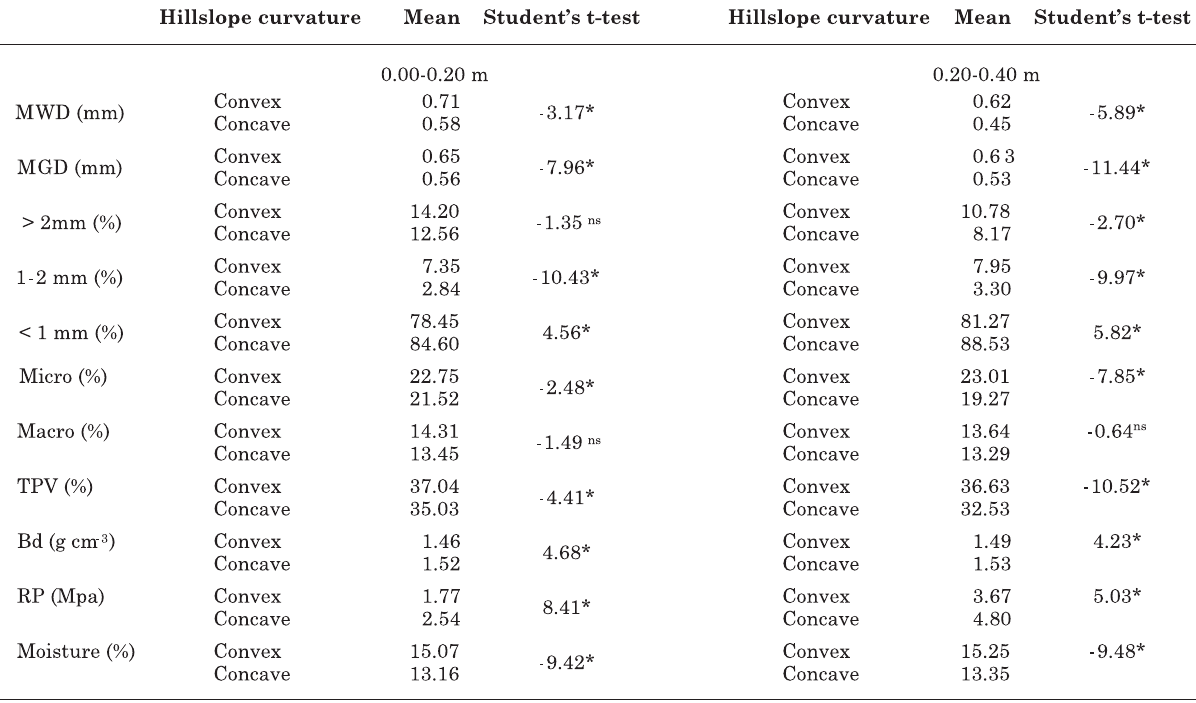
Table 4. Means in the convex and concave areas: mean weighted diameter (MWD), mean geometric diameter (MGD), aggregates > 2 mm (> 2 mm), aggregates 1–2 mm (1–2 mm), aggregates < 1 mm (< 1 mm), micropores (micro), macropores (macro), total pore volume (TPV), bulk density (Bd), resistance